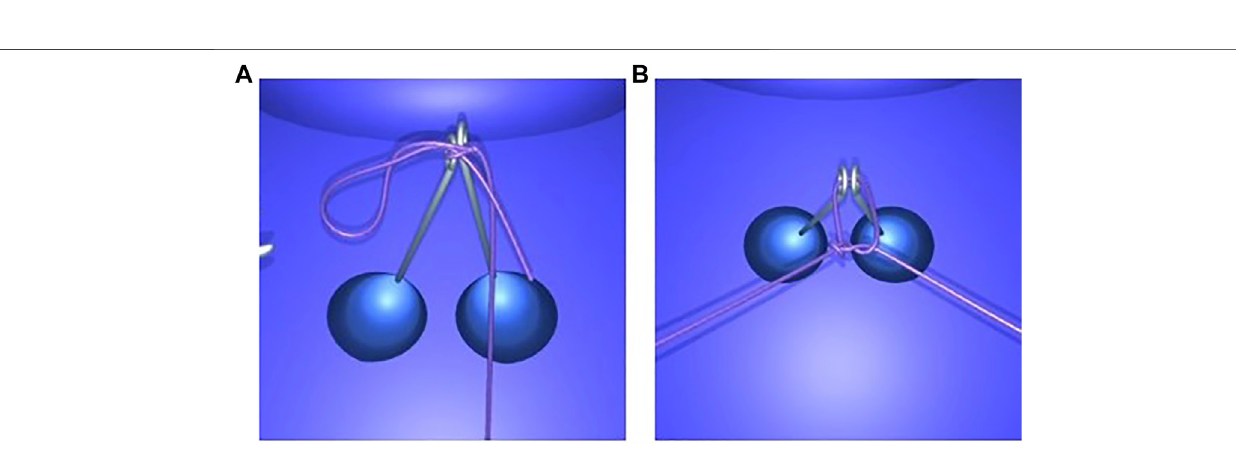
FIGURE 11 | Simulation accurately reproducing knot-tying errors. An accidental loop is created when one end of the thread is not completely pulled through the loop before tightening the knot on the rings (A) . An air knot is created when the knot is not properly guided down onto the rings before tightening it with traction on both ends of the thread (B)